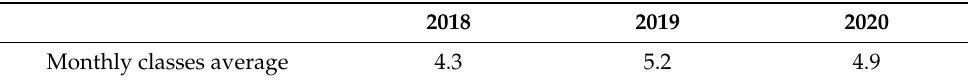
Table 2. Monthly classes